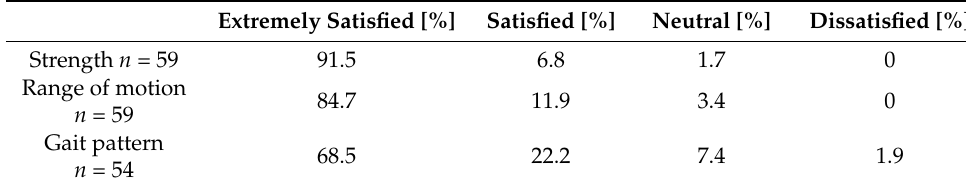
Table 2. Subjective satisfaction at follow-up.